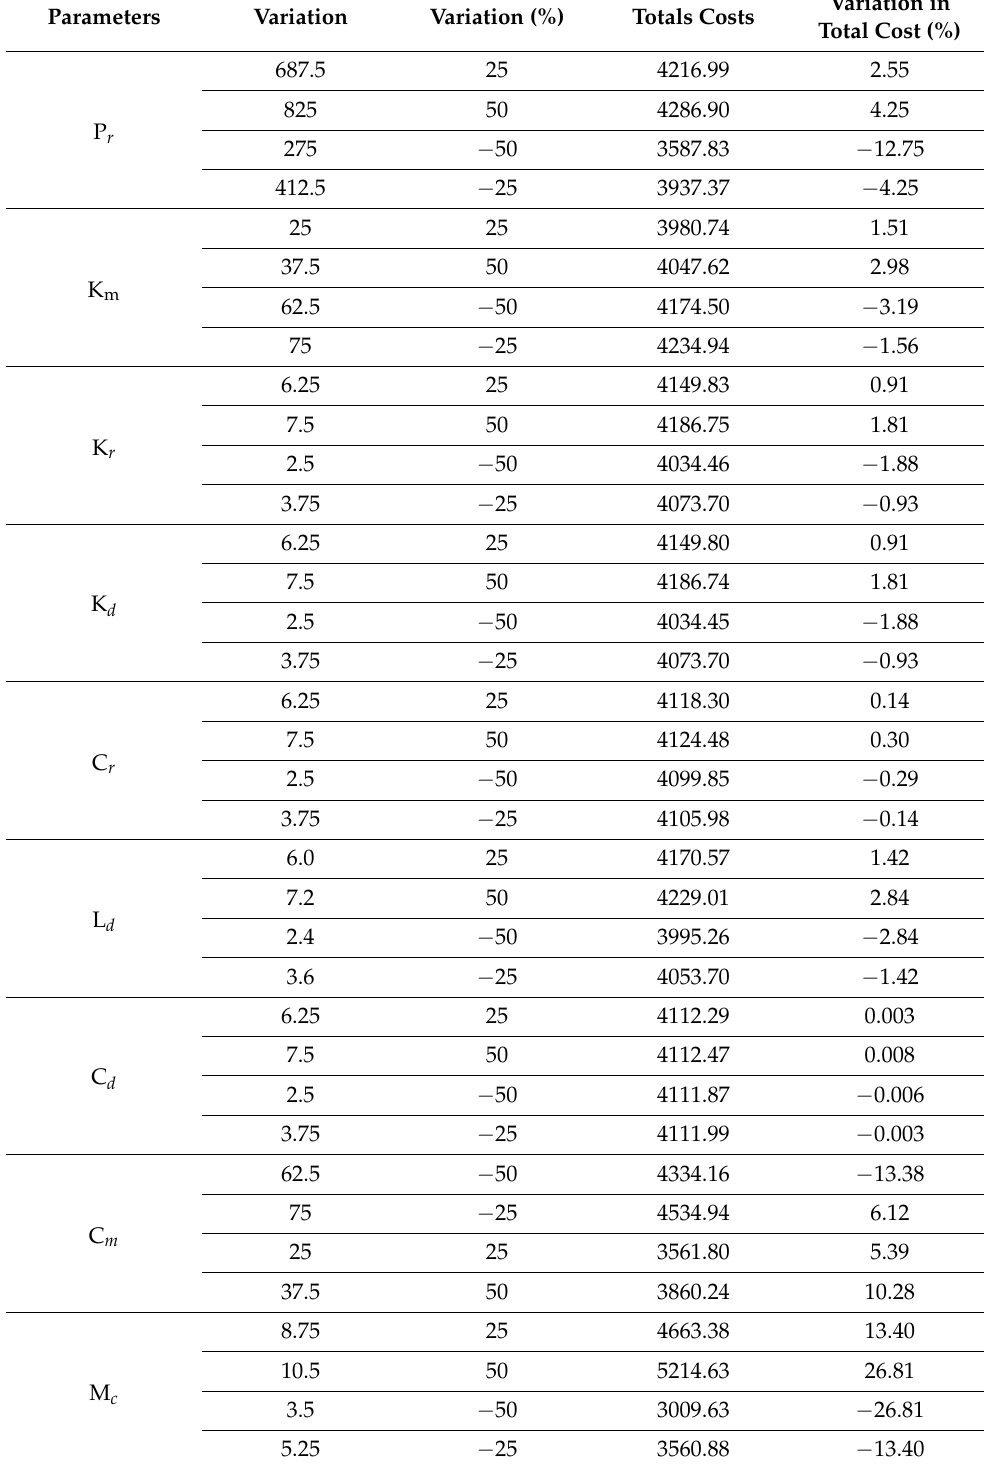
Table 4. Sensitivity analysis for basic parameters of the model presented in Case 1.